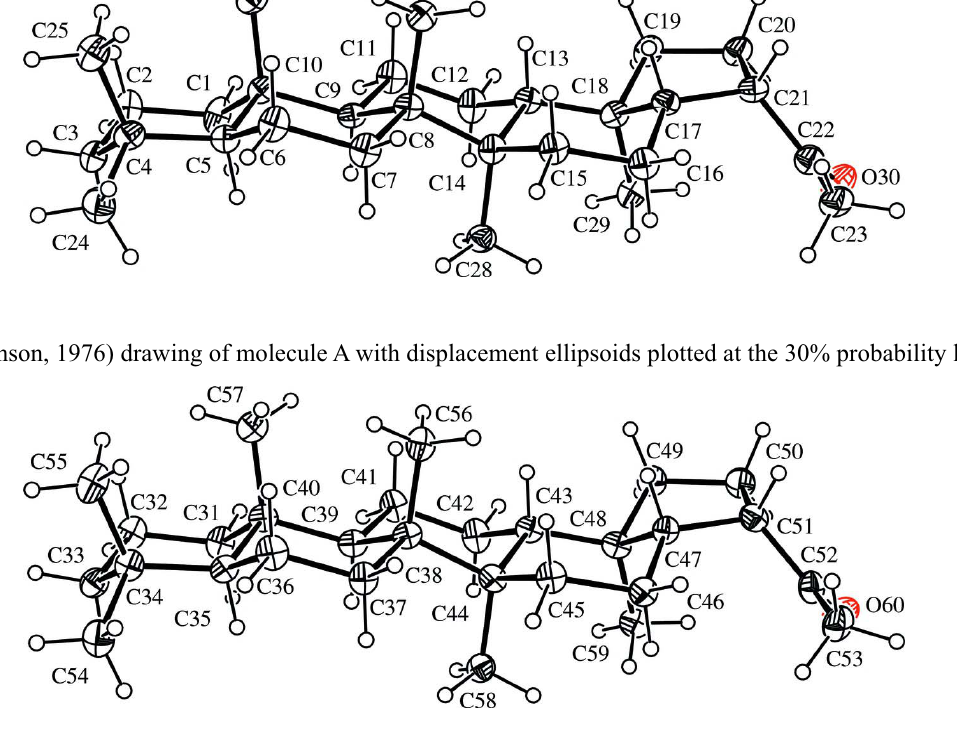
Figure 2 ORTEPII (Johnson, 1976) drawing of molecule B with displacement ellipsoids plotted at the 30% probability level. 1-(5a,5 b,8,8,11 a ,13 b -Hexamethyleicosahydro-1 H -cyclopenta[ a ]chrysen-3-yl)-